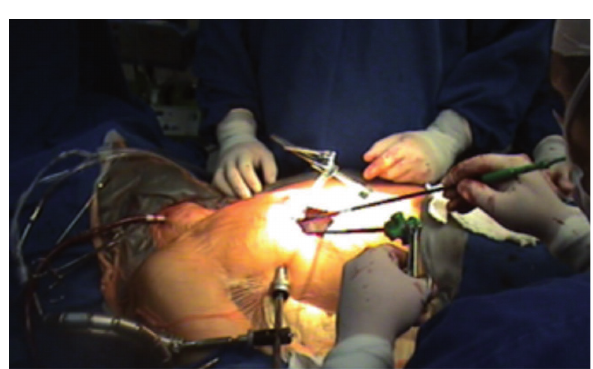
Fig. 2 - Visão panorâmica da cirurgia para valva mitral. Observa- se a canulação dupla com inclusão de uma cânula na veia jugular direita. Toracoscópio fixo por braço articulado e instrumentais longos penetrando através da mínima